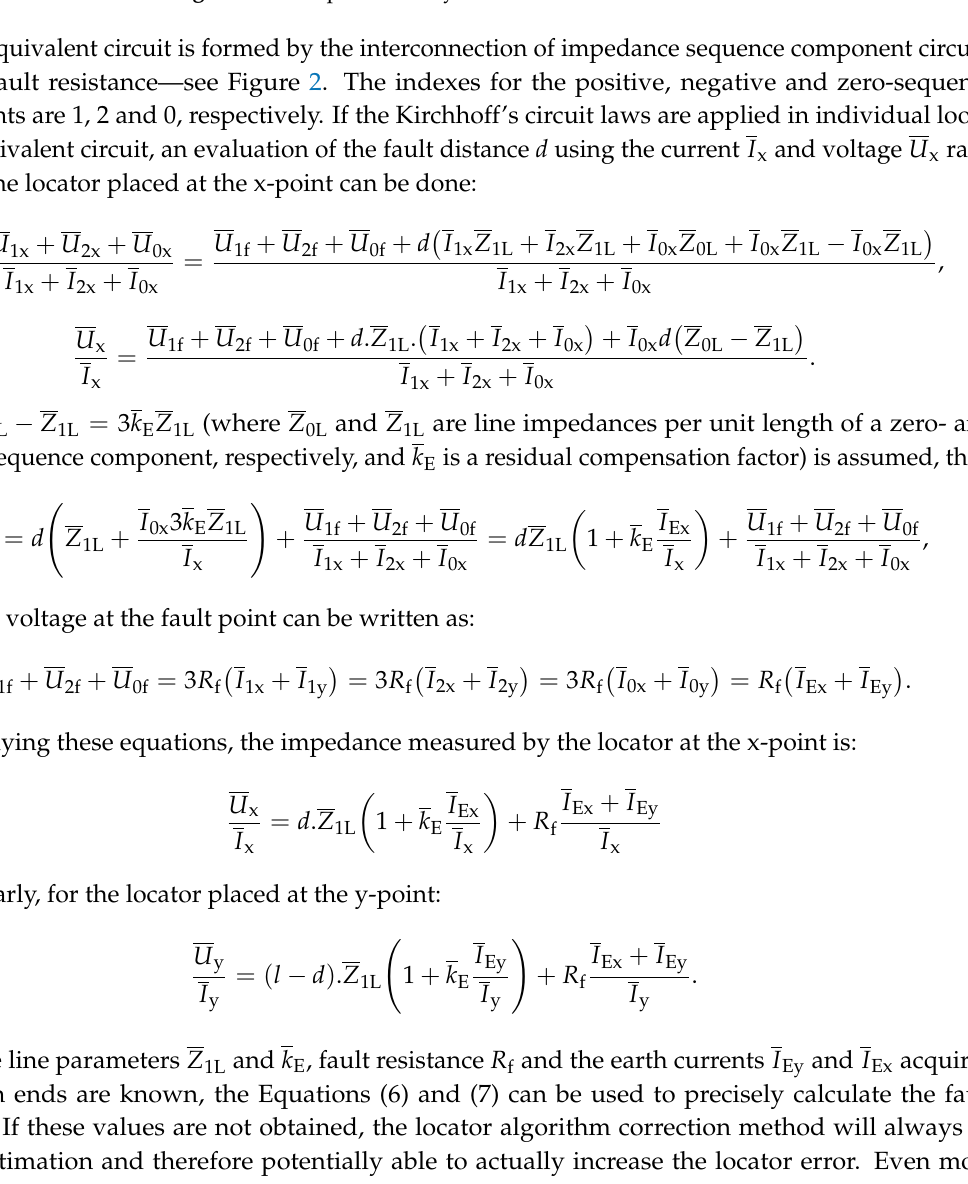
Figure 1. A simplified faulty transmission line scheme.